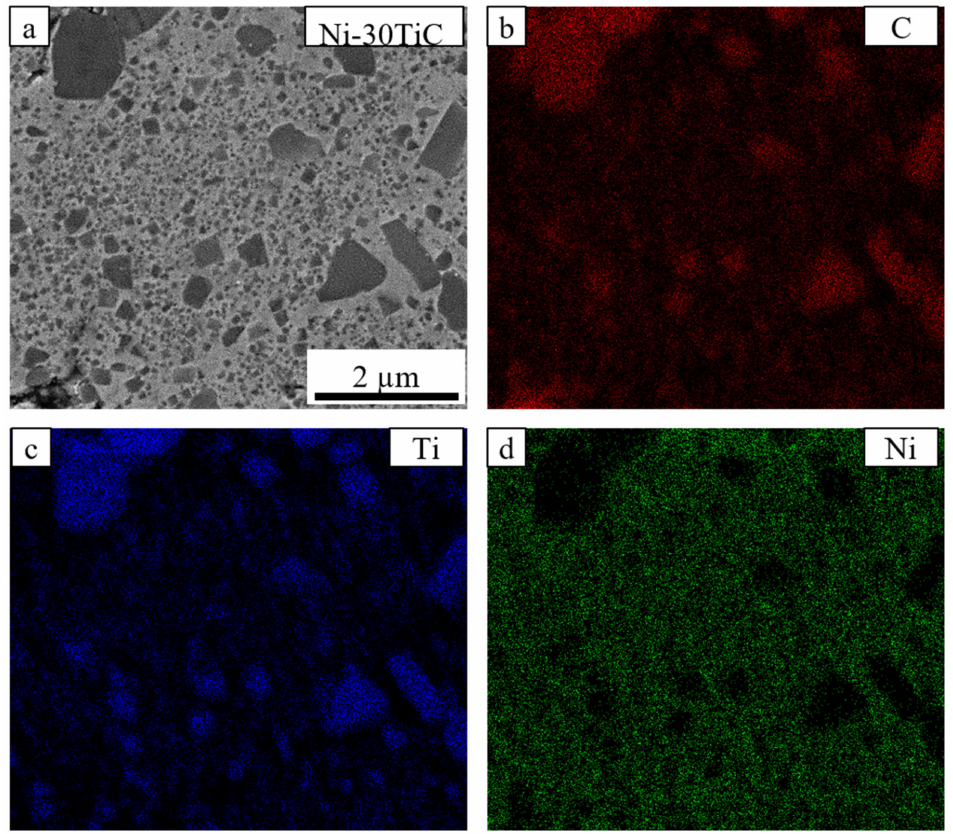
Figure 4. ( a ) Scanning electron microscope image and EDS elemental analysis of ( b ) Carbon, ( c ) Titanium, and ( e ) Nickel of Ni-30TiC-1200 ◦ C